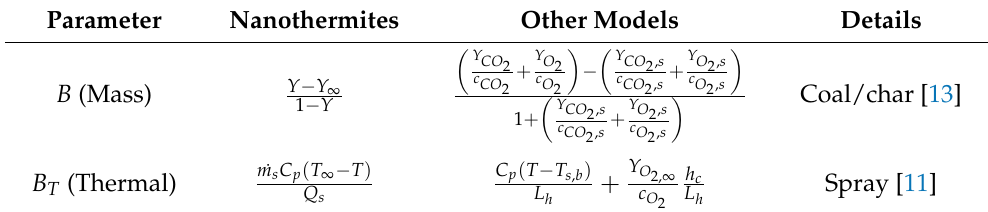
Table 1. Comparison with other single-particle combustion